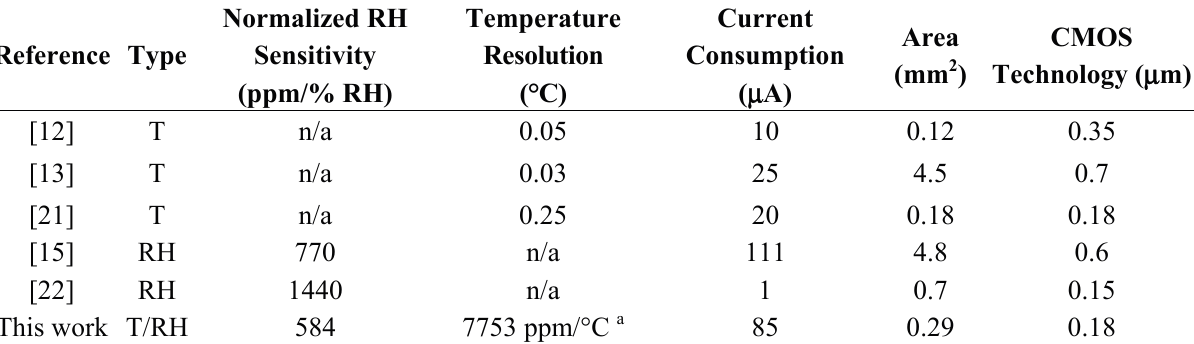
Table 2. Comparison of CMOS temperature/humidity